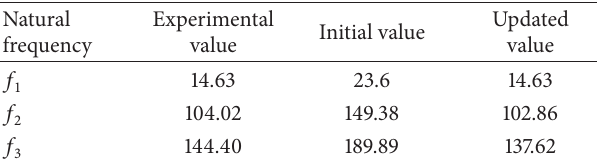
Table 3: Experimentally measured, initial, and updated natural frequencies.